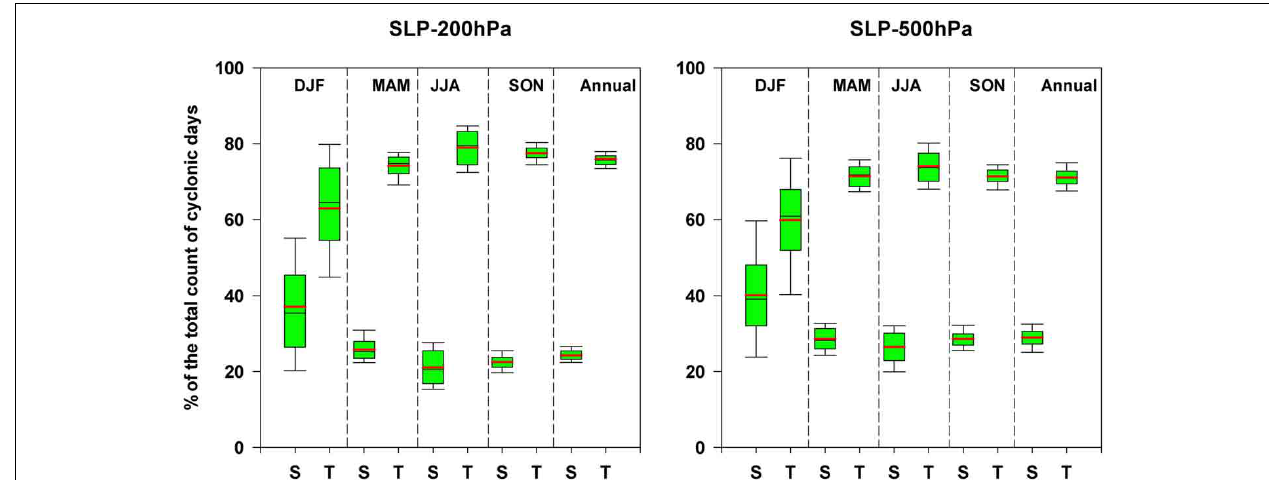
FIGURE 4 | The relative contribution of the synoptic (S) and thermal (T) lows to the total count of cyclonic days. The percentage is calculated for each season independently. The central black line shows